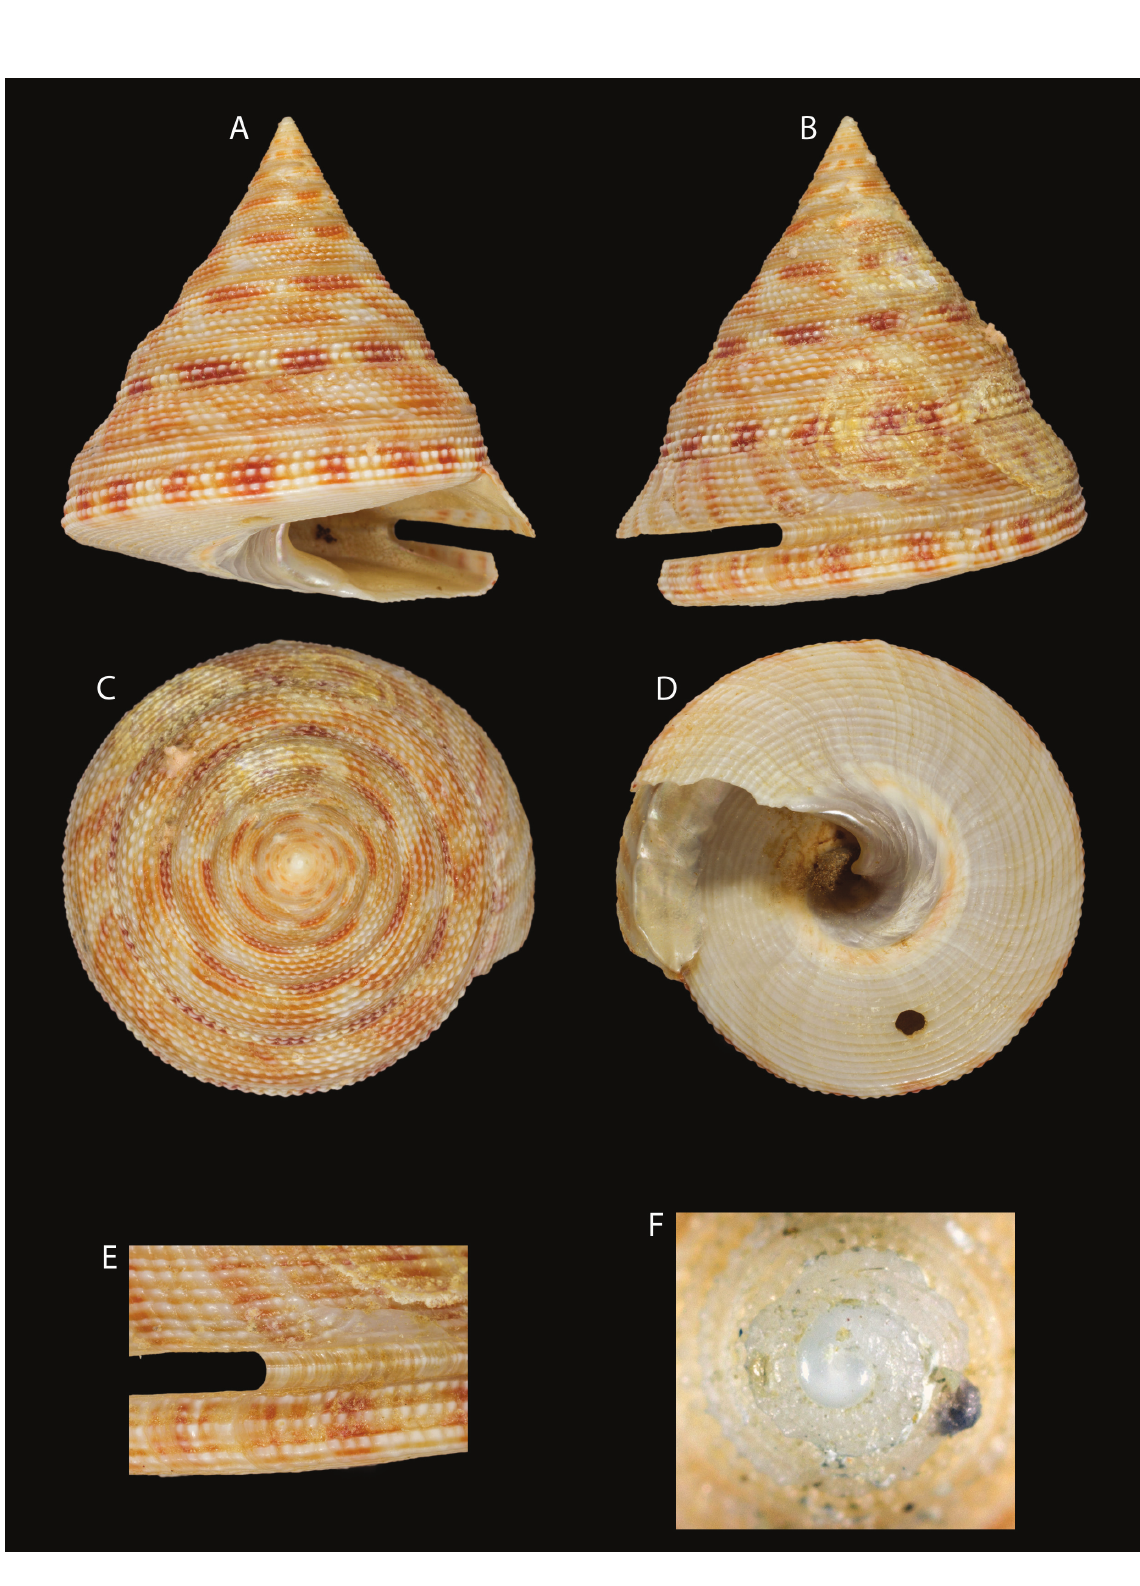
Fig. 3. Perotrochus wareni sp. nov., Mnhn-iM-2007-36460, holotype (h = 50.3 mm). A–D . teleoconch. E . slit. F .